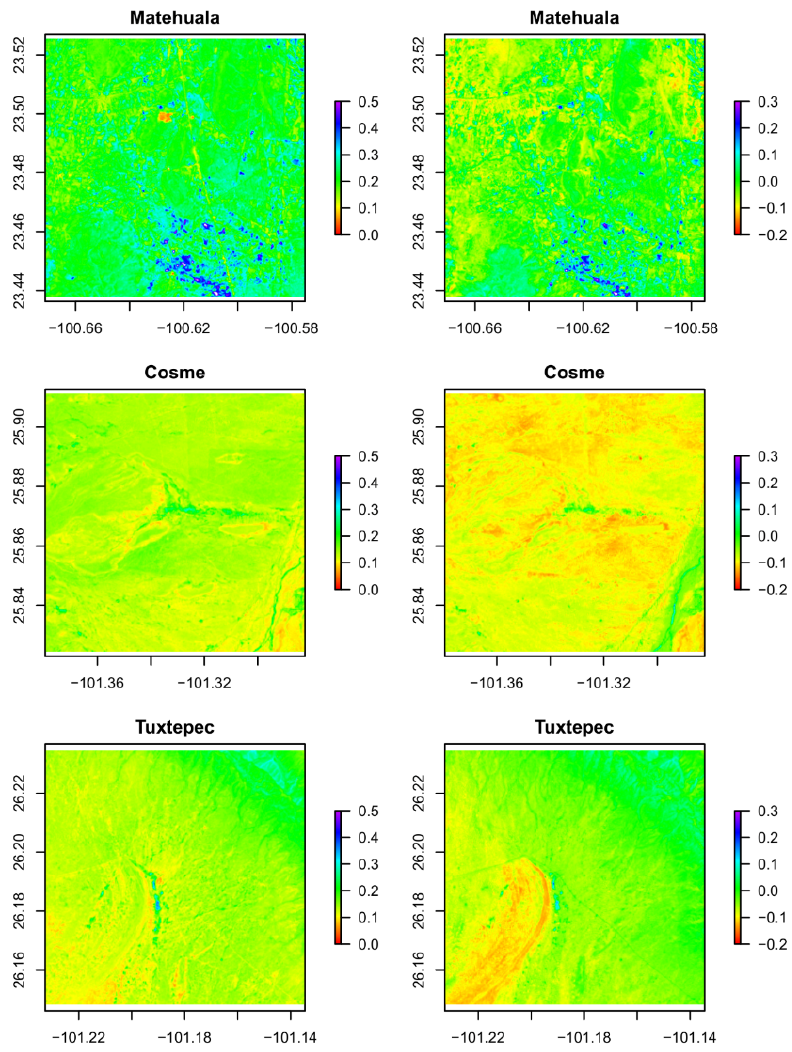
Figure 2. NDVI (left) and NDWI (right) values by location in the study area.